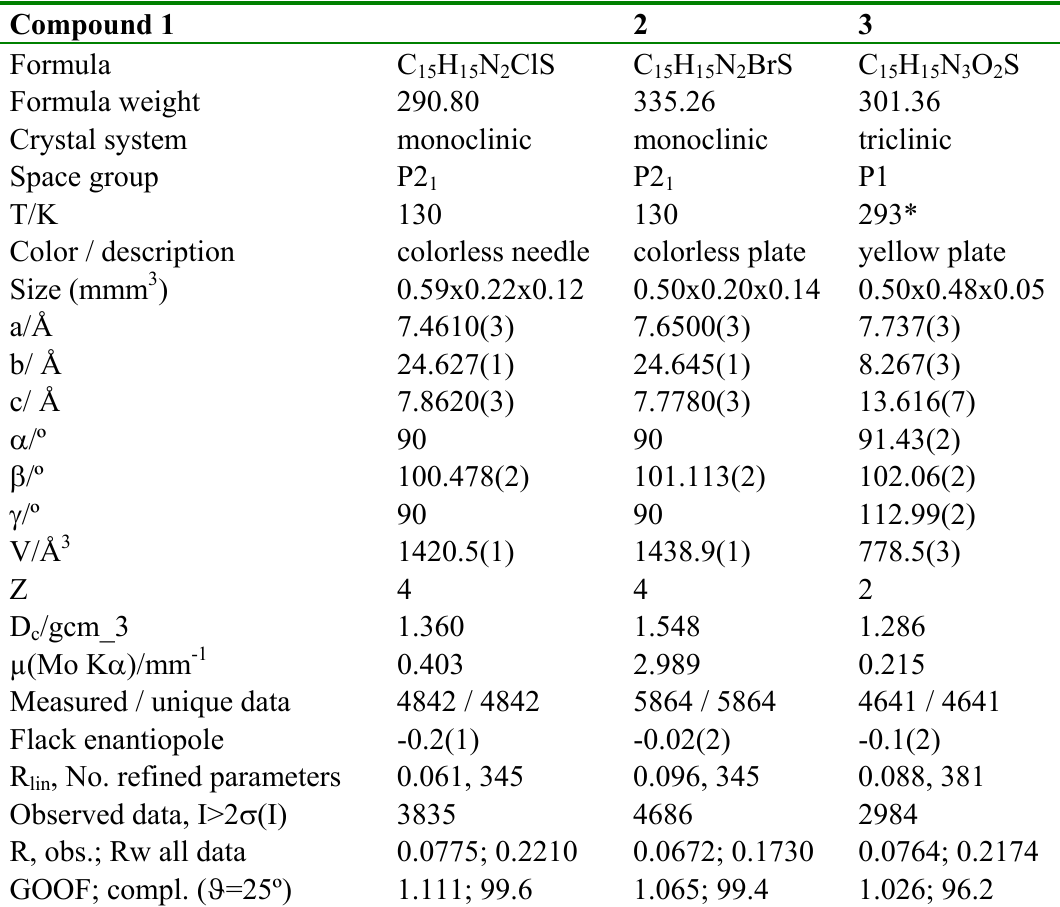
Table 1. Crystallographic data and refinement details for crystals 1 – 3 . (*) Compound 3 shows a doubled cell at 130 K with 4 independent molecules, where the cell parameters, a , b , c at room-temperature, presented here, are related to those at 130 K, A , B , C , via